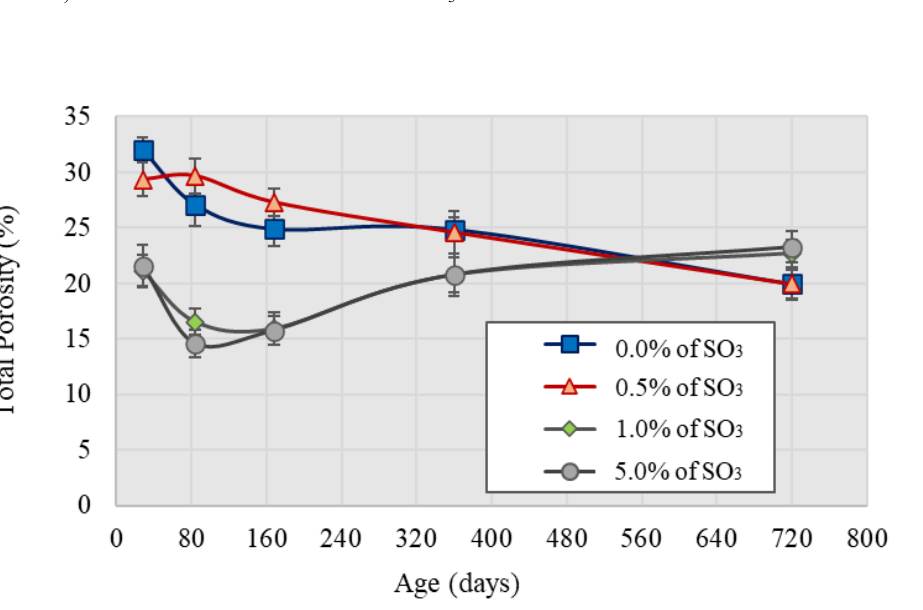
Figure 5. Total porosity monitoring for the series studied (0.0%, 0.5%, 1.0% and 5.0% SO 3